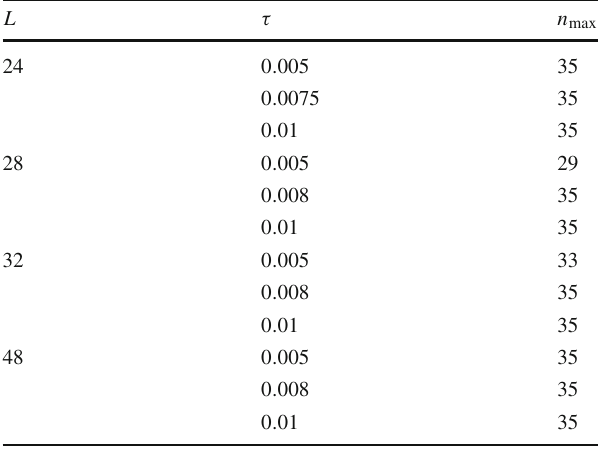
Table 2 Summary of the ensembles for N c = 3 and N f = 2 staggered fermions. The order n max is the highest order at which the plaquette p n has been